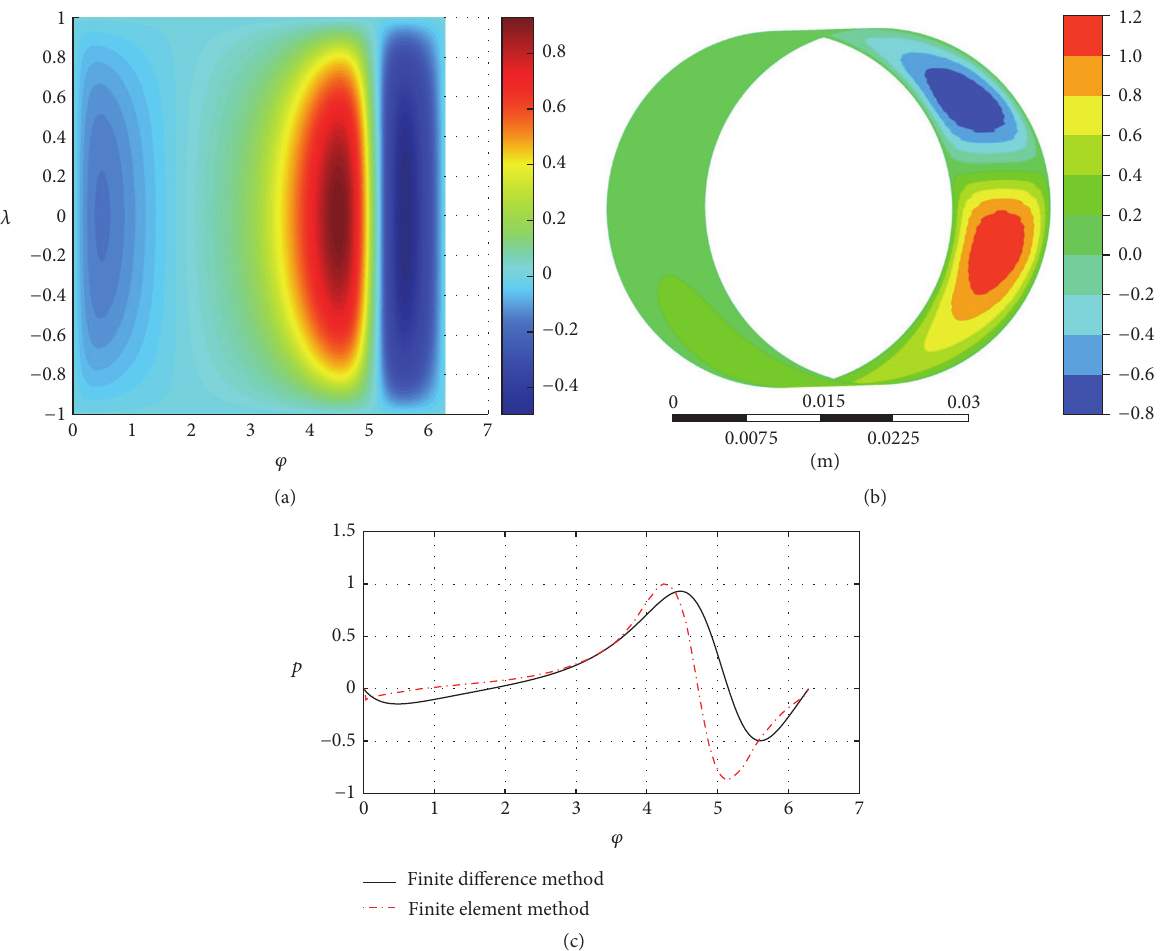
Figure 8: Nondimensional pressure nephogram of the PGJB by (a) the finite difference method and (b) the finite element method; (c) the corresponding circumferential pressure distribution curve of the cross-section of PGJB by the finite difference method and the finite element